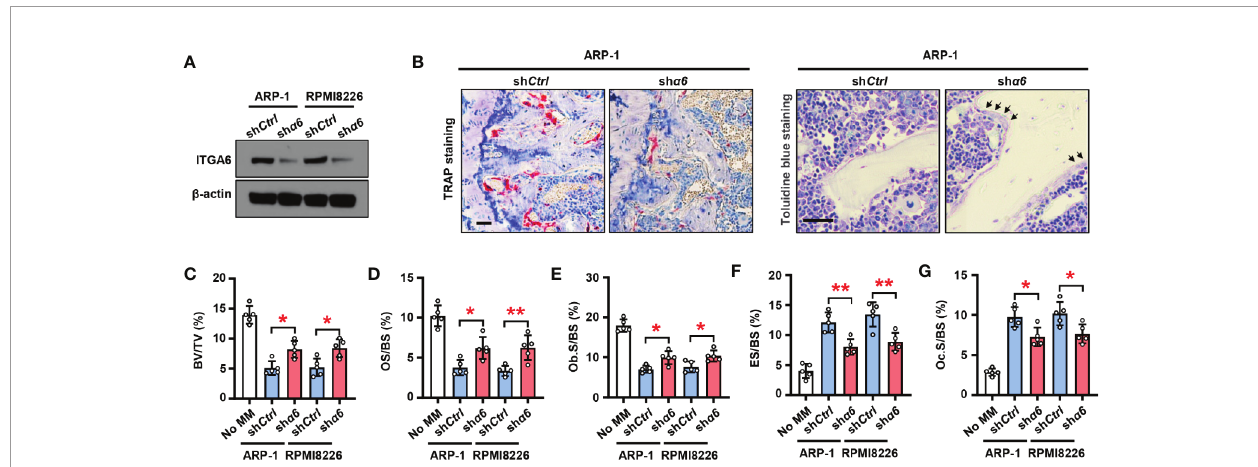
FIGURE 2 | Myeloma cells integrin a 6 inhibits osteoblast differentiation and enhances osteoclast differentiation in vivo . Myeloma cell lines ARP-1 or RPMI 8226 were infected with lentivirus carrying nontargeted shRNA (sh Ctrl ) or ITGA6 shRNA (sh a 6 ). (A) Western blotting shows the level of ITGA6 in sh Ctrl or sh a 6 myeloma cells. Levels of b -actin served as loading control. Representative images are shown from three independent experiments. (B – G) SCID mice were injected sh Ctrl or sh a 6 myeloma cells. Mice without myeloma cell injection served as baseline parameters for bone analysis. After 4 weeks, mouse femurs were extracted, fi xed, TRAP- or toluidine blue-stained, and analyzed. (B) Representative images of TRAP- or toluidine blue-stained femurs of myeloma-bearing mice. Scale bar: 50 m m. (C – G) Shown are the percentage of bone volumes versus total volumes (BV/TV) (C) , the percentages of osteoid surface (OS/BS) (D) and total bone surface lined with osteoblasts (Ob.S/BS) (E) , the percentages of bone surface eroded by osteoclasts (ES/BS) (F) and bone surface covered with osteoclasts (Oc.S/BS) (G) . Data are means ± SD ( n = 5 mice/group, three replicate studies). * P < 0.05; ** P < 0.01. P values were determined using one-way